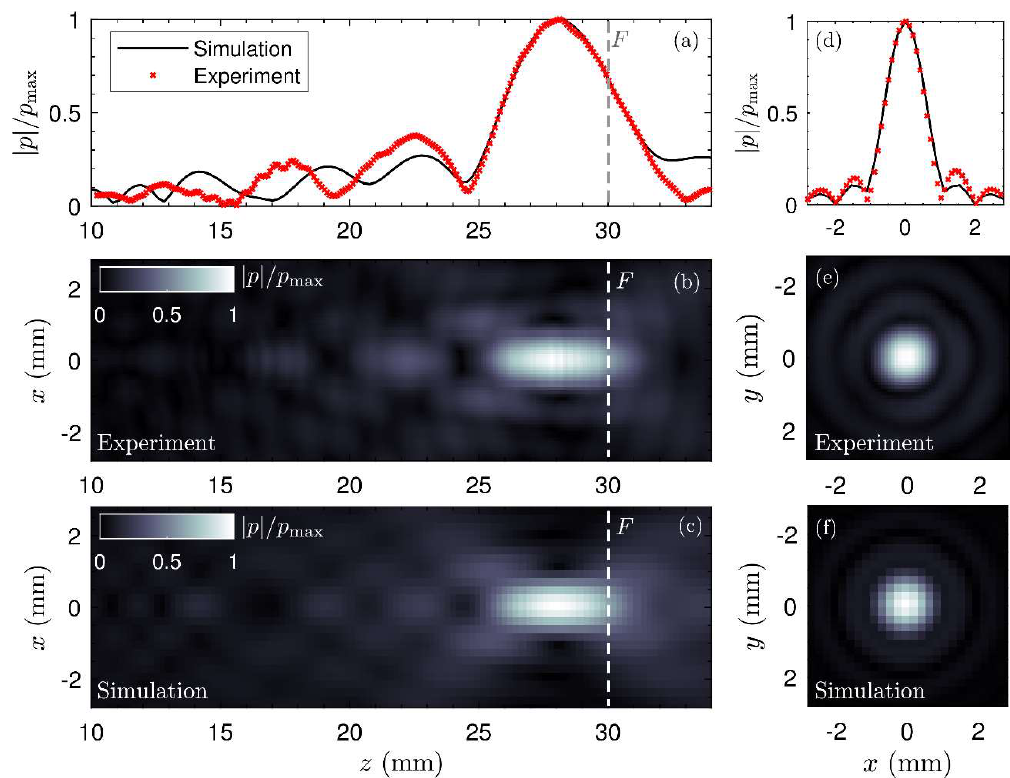
Figure 9. Results of the experimental validation test. ( a ) Experimental (red markers) and simulated (black continuous) normalized pressure field distribution measured at the axis of symmetry. Pressure field distribution in the sagittal plane, P ( x , z ), obtained ( b ) experimentally and ( c ) numerically. ( d ) Experimental (red markers) and simulated (black continuous) normalized pressure field distribution in the transverse direction x measured at the focal spot. Corresponding pressure distributions in the transverse plane, P ( x , y ), obtained ( e ) experimentally and ( f ) numerically.